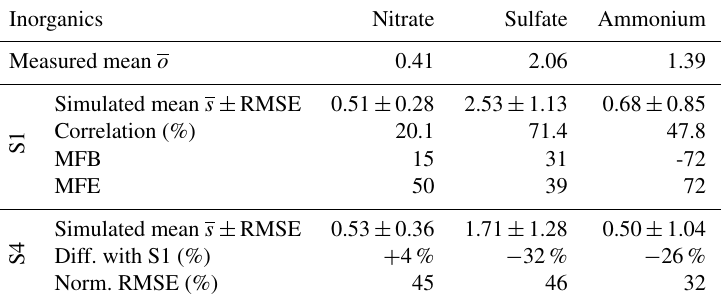
Table 8. Comparisons of simulated PM 1 inorganic daily concentrations to observations (concentrations are in µgm − 3 ) using S1 and S4 during the 2012 summer. Inorganics Nitrate Sulfate Ammonium Measured mean o